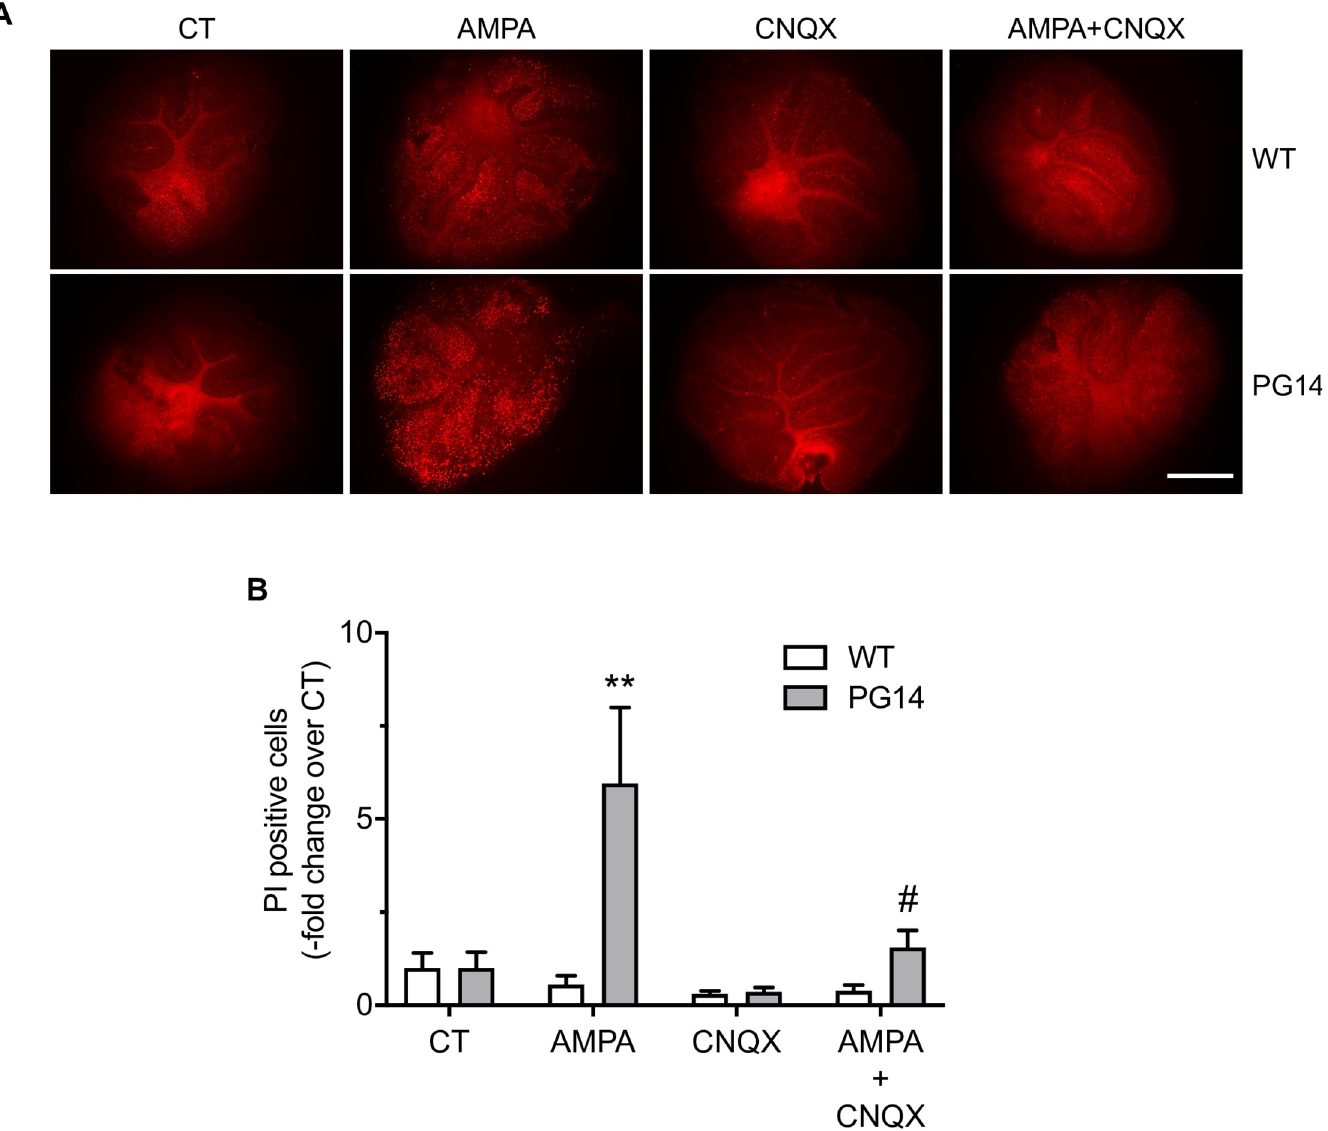
Fig 8. Cultured organotypic cerebellar slices from Tg(PG14) mice show increased vulnerability to AMPA toxicity. (A) Organotypic cerebellar slices from WT and PG14 mice were cultured for 15 days before exposure to 50 μ M AMPA, 25 μ M CNQX, or AMPA and CNQX, for 24h. Scale bar 500 μ m. (B) The PI-positive cells were counted after 24h and expressed as the–fold change from vehicle-treated cells (CT). Data are the mean ± SEM of 9–24 cerebellar slices from three independent experiments. �� p < 0.01 and vs . PG14 CT; # p < 0.05 vs . PG14 AMPA by two-way ANOVA, Tukey’s post-hoc